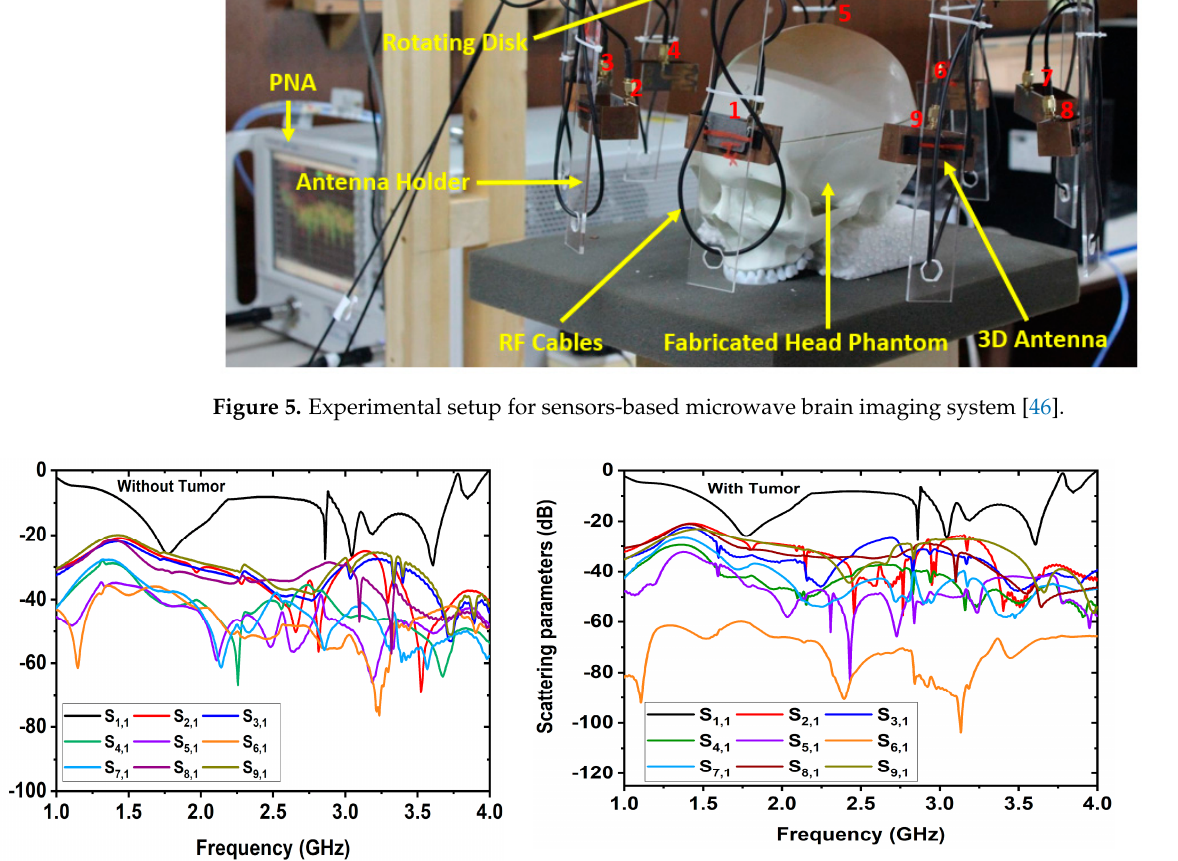
Figure 6. Reflected scattering bio signals received by the receiving antenna sensors: ( a ) without tumor, ( b ) with tumor.